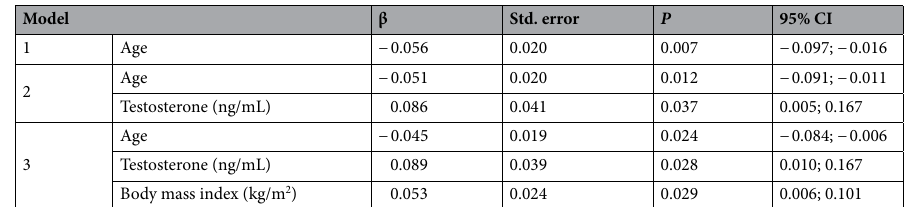
Table 3. Beta coefficients for testosterone, age and BMI in adjusted models of prediction of T score of the hip, using stepwise regression. a. Dependent variable: T score hip. b. Predictors: E2, testosterone, DHEA, androstenedione, age, race, BMI, alcohol, smoking habits, age of menarche, type of menstrual cycles, parity, age of menopause, years since menopause, vaginal estrogen use.